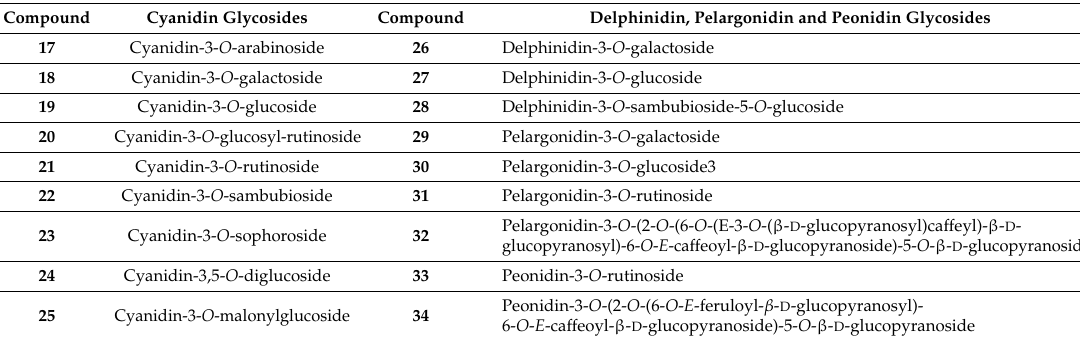
Table 1. Structural diversity of anthocyanins with reported ameliorative effect on insulin resistance